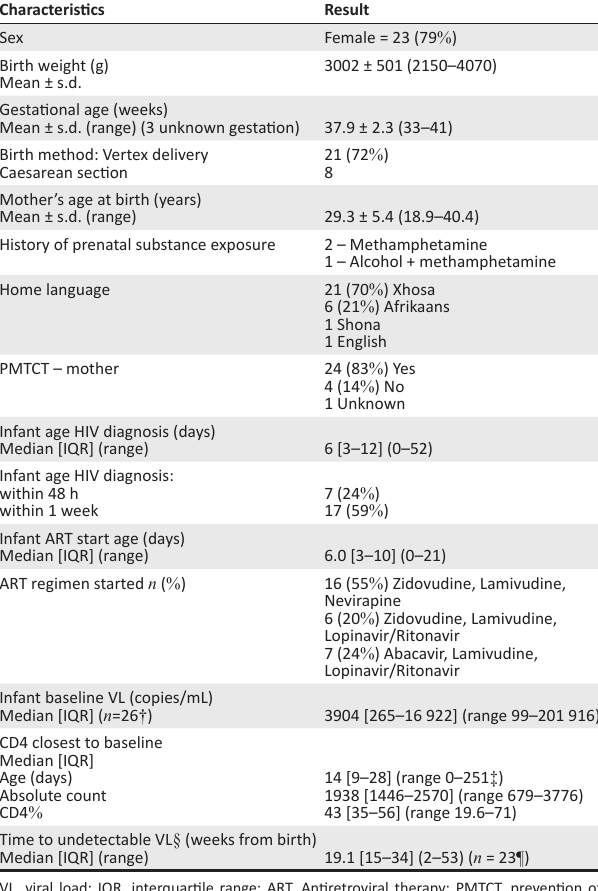
TABLE 1: Demographic characteristics of participants ( N = 29).